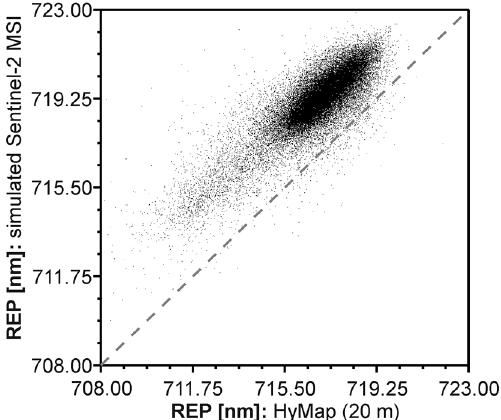
Figure 5. Scatterplot of the REP values extracted from HyMap data (20-m spatial resolution) and simulated S2 dataset (20-m spatial resolution) .